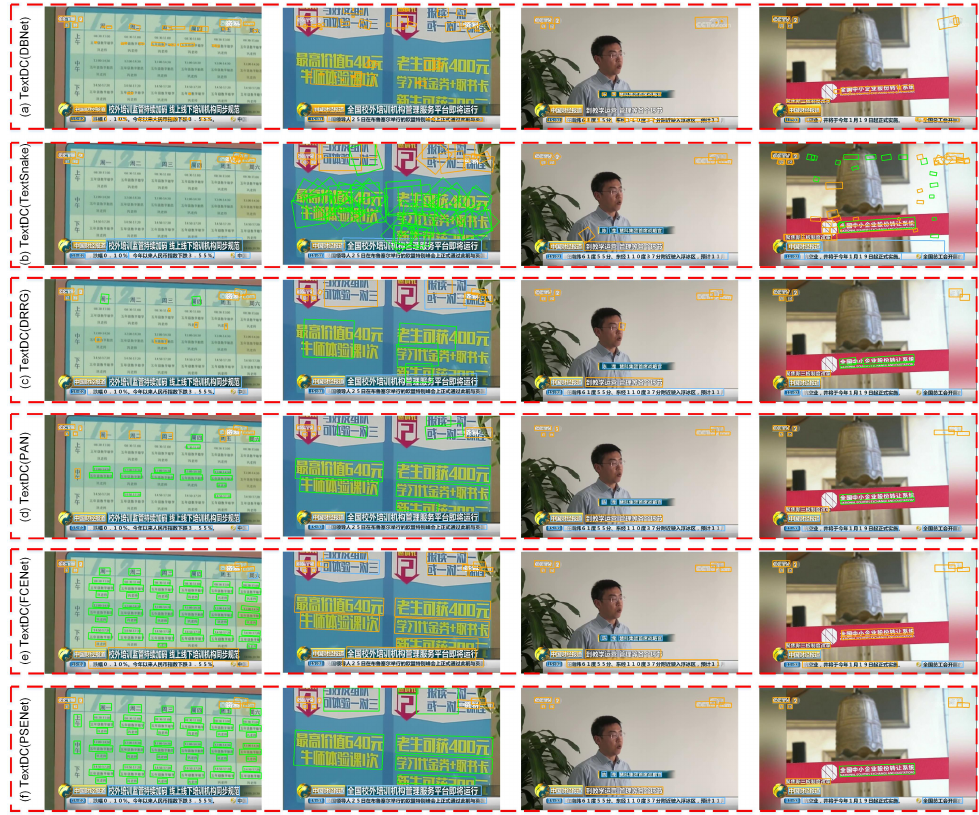
Figure 6. Visualization results of different methods on the proposed Text3C dataset. The illustrated detection and classification results were predicted by ( a ) TextDC(DBNet), ( b ) TextDC(TextSnake), ( c ) TextDC(DRRG), ( d ) TextDC(PAN), ( e ) TextDC(FCENet), and ( f ) TextDC(PSENet), respectively. Notably, overlaid, layered, and scene text instances are indicated by orange, blue, and green boxes, respectively. Best viewed in color and zoomed in.